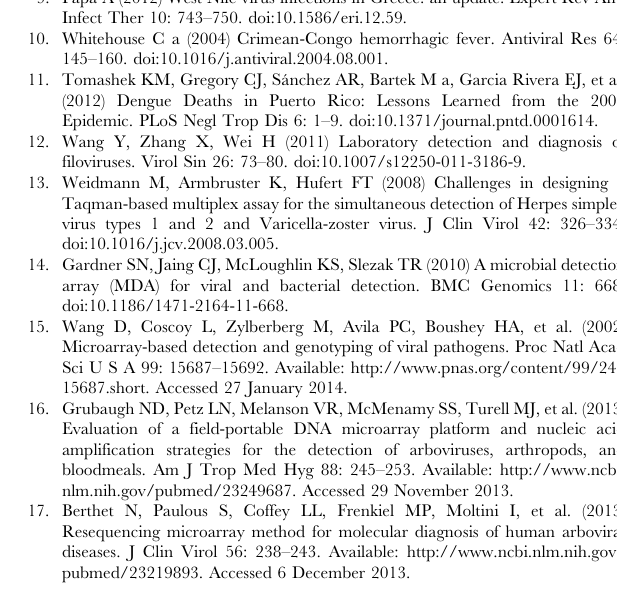
Table S1 Modified WT amplification of non-clinical